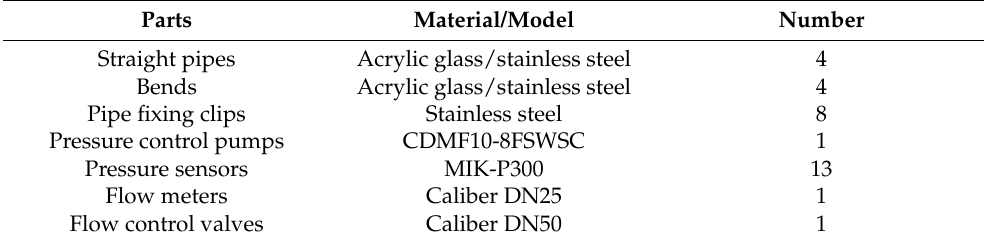
Table 1. Piping laboratory